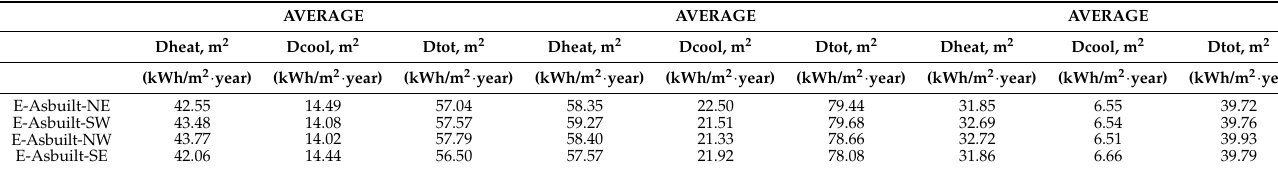
Table 4. Annual thermal demand values obtained for the as-built configuration.